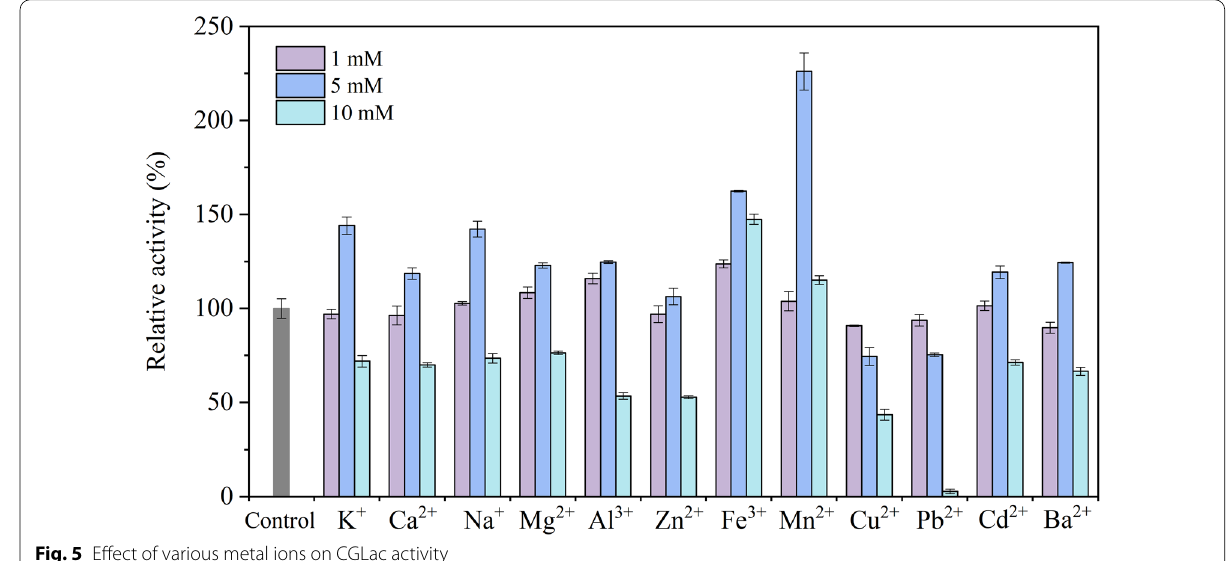
Fig. 5 Effect of various metal ions on CGLac activity